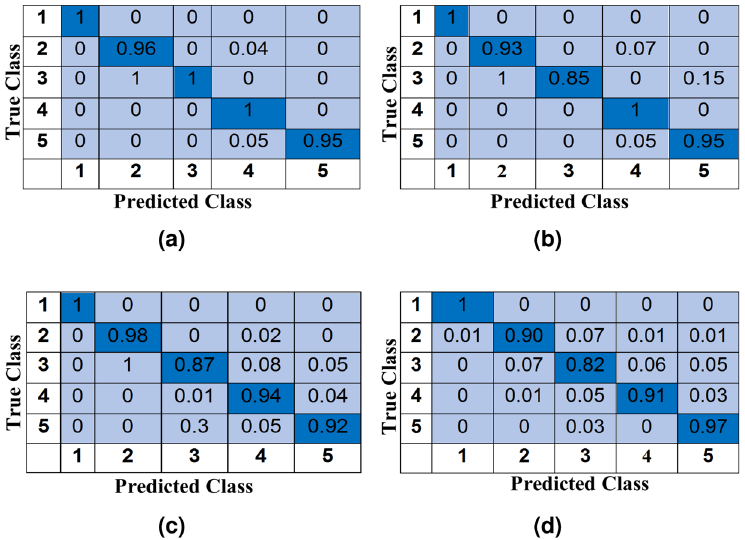
Figure 9. Normalised confusion matrices with maximum accuracy for all 4 phases of the experiment. The class labels for classes 1 to 5 are given in Table 4. In here ( a ) is representing Phase-1 with an accuracy of 98.22%,